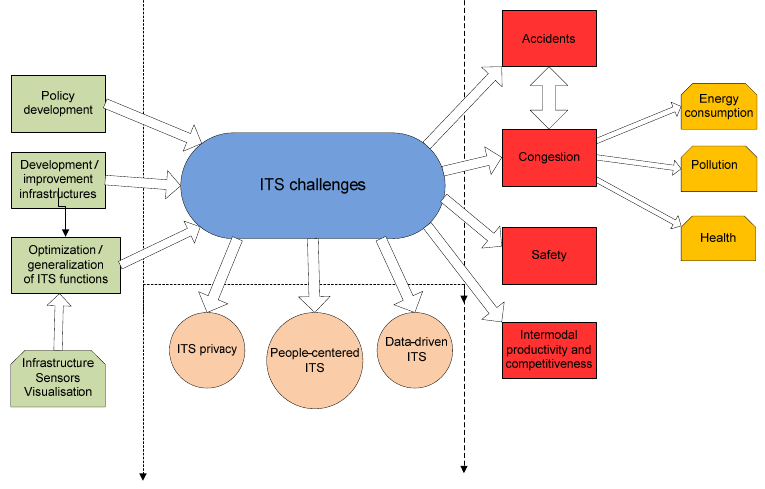
Figure 1. Overview of Intelligent Transport Systems (ITS): activities, challenges and problems.